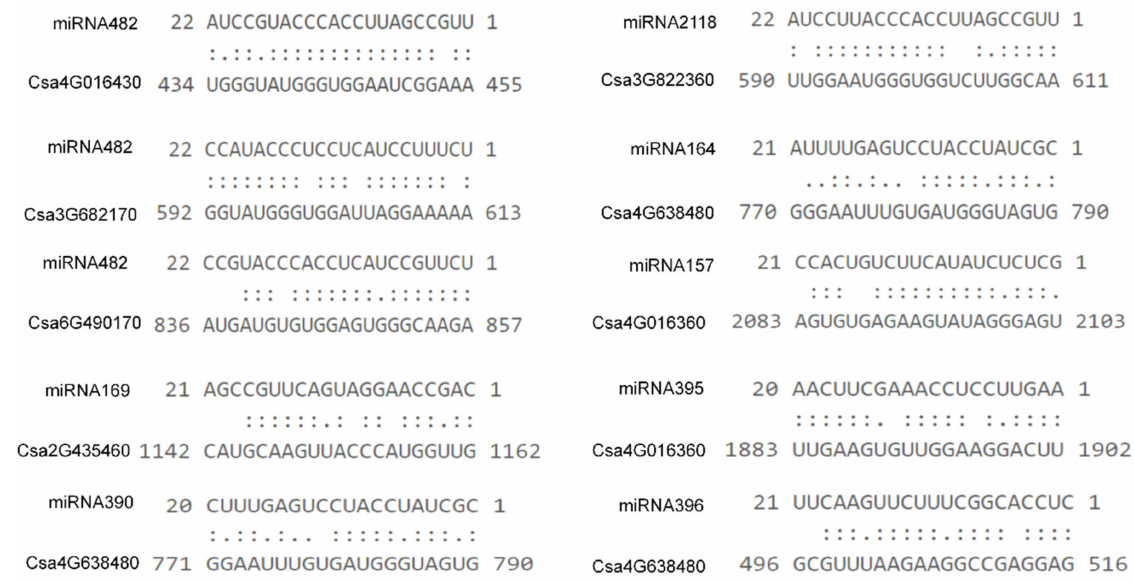
Figure 12. The predicted binding site of the CNL genes targeted by miRNAs in cucumber plants. Two dots indicated paired successfully between bases, and one dot indicated that there is also a pairing between U and G in the secondary structure. Blank space indicated that two bases failed to be